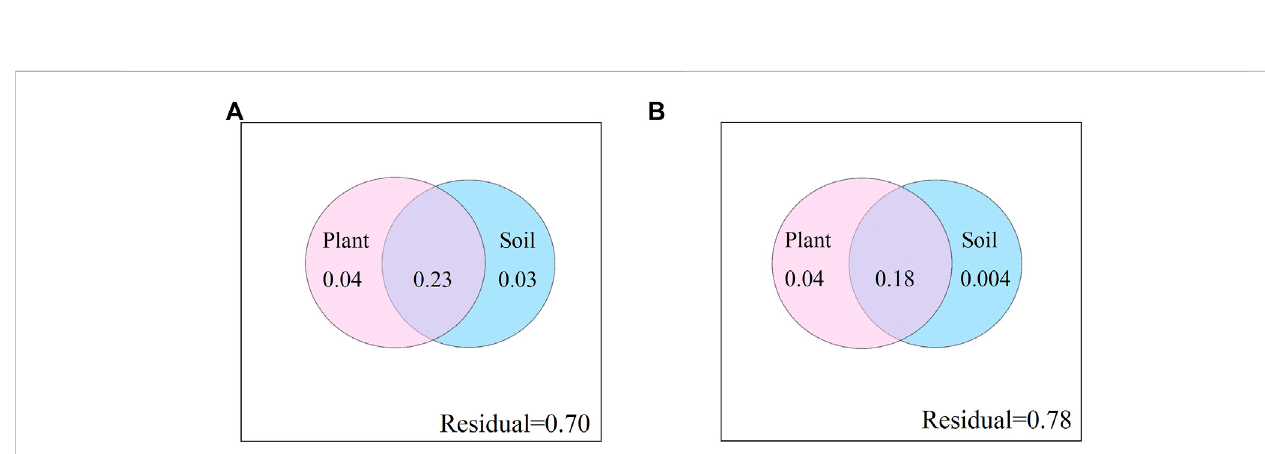
FIGURE 4 Variance partitioning of structure of CAZyme gene composition among plant community composition and soil characteristics. (A) :0 – 10 cm; (B) : 10 – 20